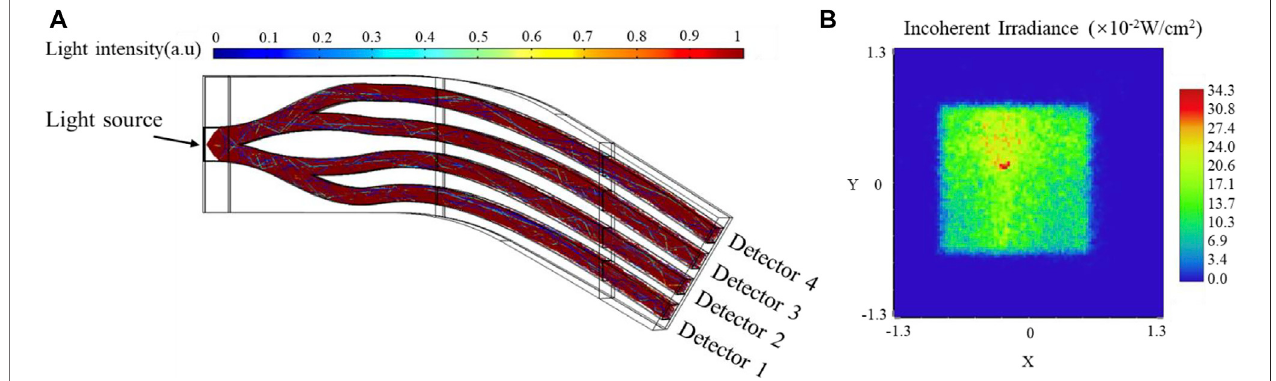
FIGURE 3 | Simulation result of the undeformed sensor (A) Ray tracing, (B) The inherent radiation distribution map of channel 1.